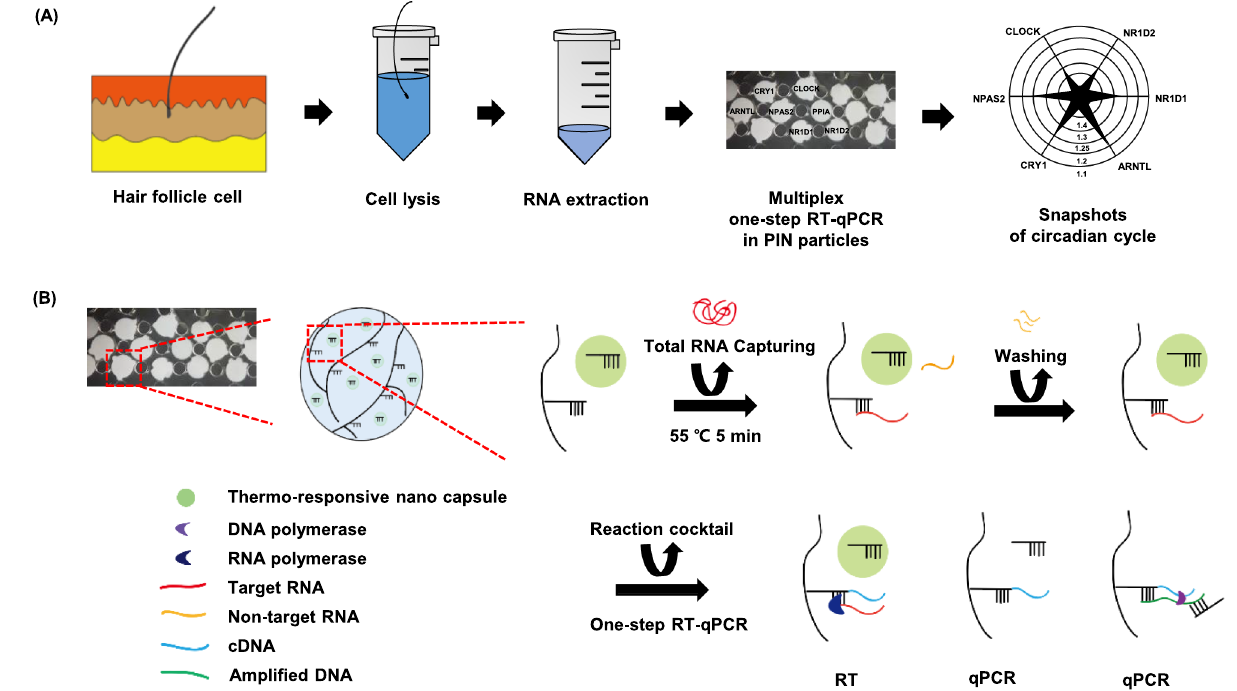
Figure 1. Principle of one step RT-qPCR process in primer immobilized network(PIN) microparticles. ( A ) Schematic representation of circadian snapshots for multiplex detection in one step RT qPCR process from human hair follicle Gene expression level was demonstrated using the C t values of the PIN particles. ( B ) Process of RNA capturing using microparticles possessing forward and reverse primer was demonstrated at 55 ºC for 5 min. After the washing process, the one step RT-qPCR cocktail mix was introduced to perform one step RT-qPCR process The qPCR primer was embedded in the nanocapsule (a thermo responsive polymer represented in green, tPIN to prevent them to participate in the RT (reverse transcription) process In the qPCR pre denaturation process, the nanocapsule was melted at 95 ºC where the qPCR primer is free to move thus, enabling the qPCR